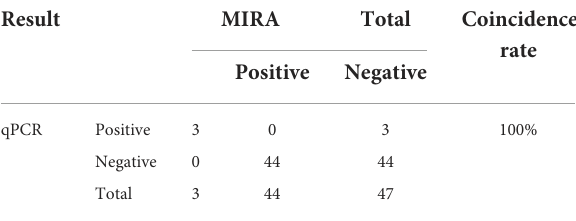
TABLE 2 Comparison of real-time PCR and MIRA results for clinical samples.